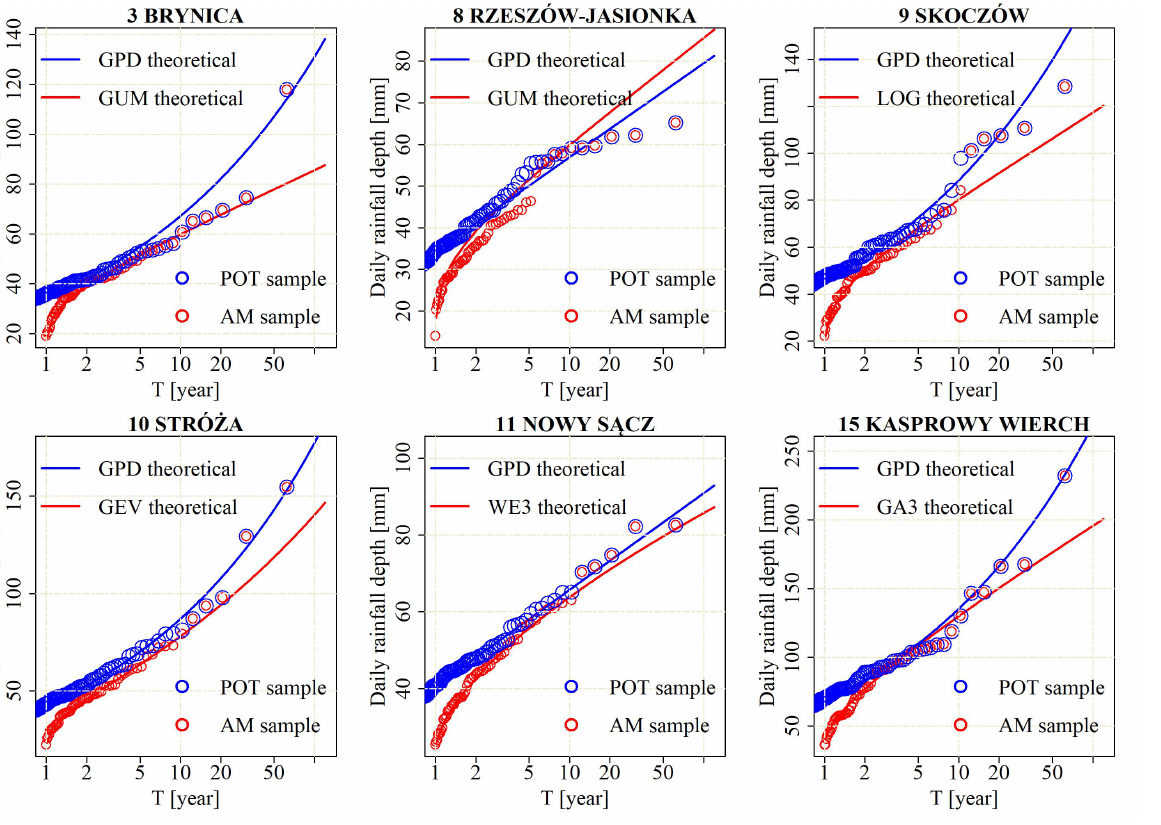
Figure 7. Design rainfall depth computed using the POT-based and AM-based methods. The circles represent the sample values, while the continuous lines are theoretical distributions: GPD (blue line, POT-based method) and the theoretical distribution that was selected by using the AIC (red line, AM-based